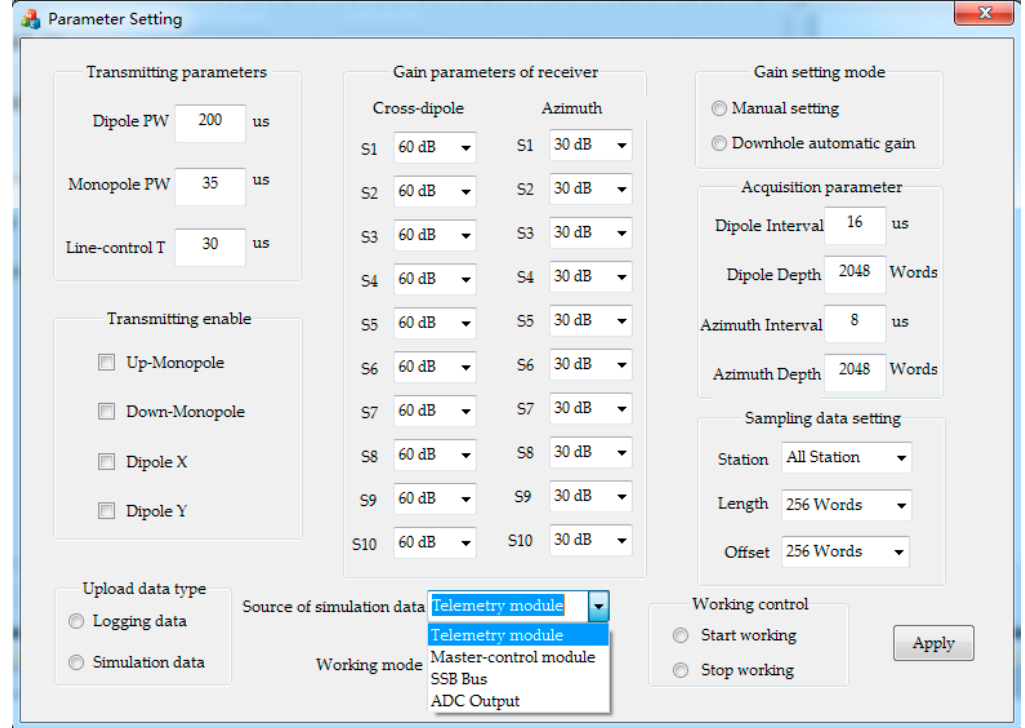
Figure 8. Parameter setting for intelligent diagnosis.